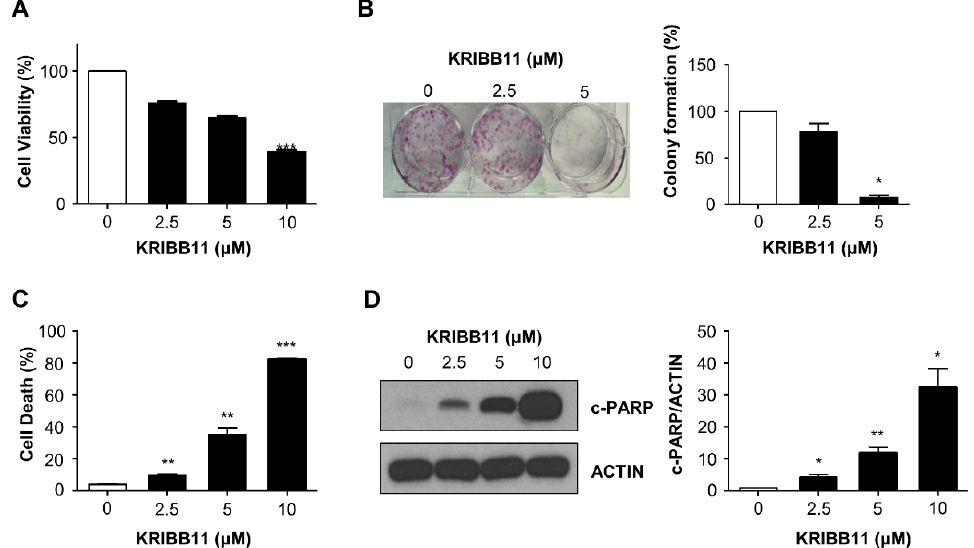
Figure 1. Effect of KRIBB11 on the survival of A172 cells. ( A ) A172 cells were treated with an increasing dose of KRIBB11 for 72 h, and the relative survival was determined using MTT assay. Data was presented as mean ± SE of triplicate experiments. ( B ) Colony forming assay was performed with 1000 cells/well of A172 cells treated with 0, 2.5, or 5 µ M of KRIBB11. After 15 days, the colony number was counted with crystal violet staining ( left ). The mean value from three independent experiments were provided as percentage of control ( right ). ( C ) KRIBB11-induced cell death was represented as percentage of PI positive cells from total cells. Values are mean ± SE of three independent experiments. ( D ) Western blotting for cleaved PARP (c-PARP) was performed with lysates from A172 cells treated with various concentrations of KRIBB11 ( left ). Induction of apoptosis was evaluated by quantitation of c-PARP levels from three independent experiments with densitometric analysis after normalizing to β -Actin using Image J software. Data are mean ± SE of three independent experiments ( right ). * p < 0.05, ** p < 0.01, and *** p < 0.001 with respect to control values.